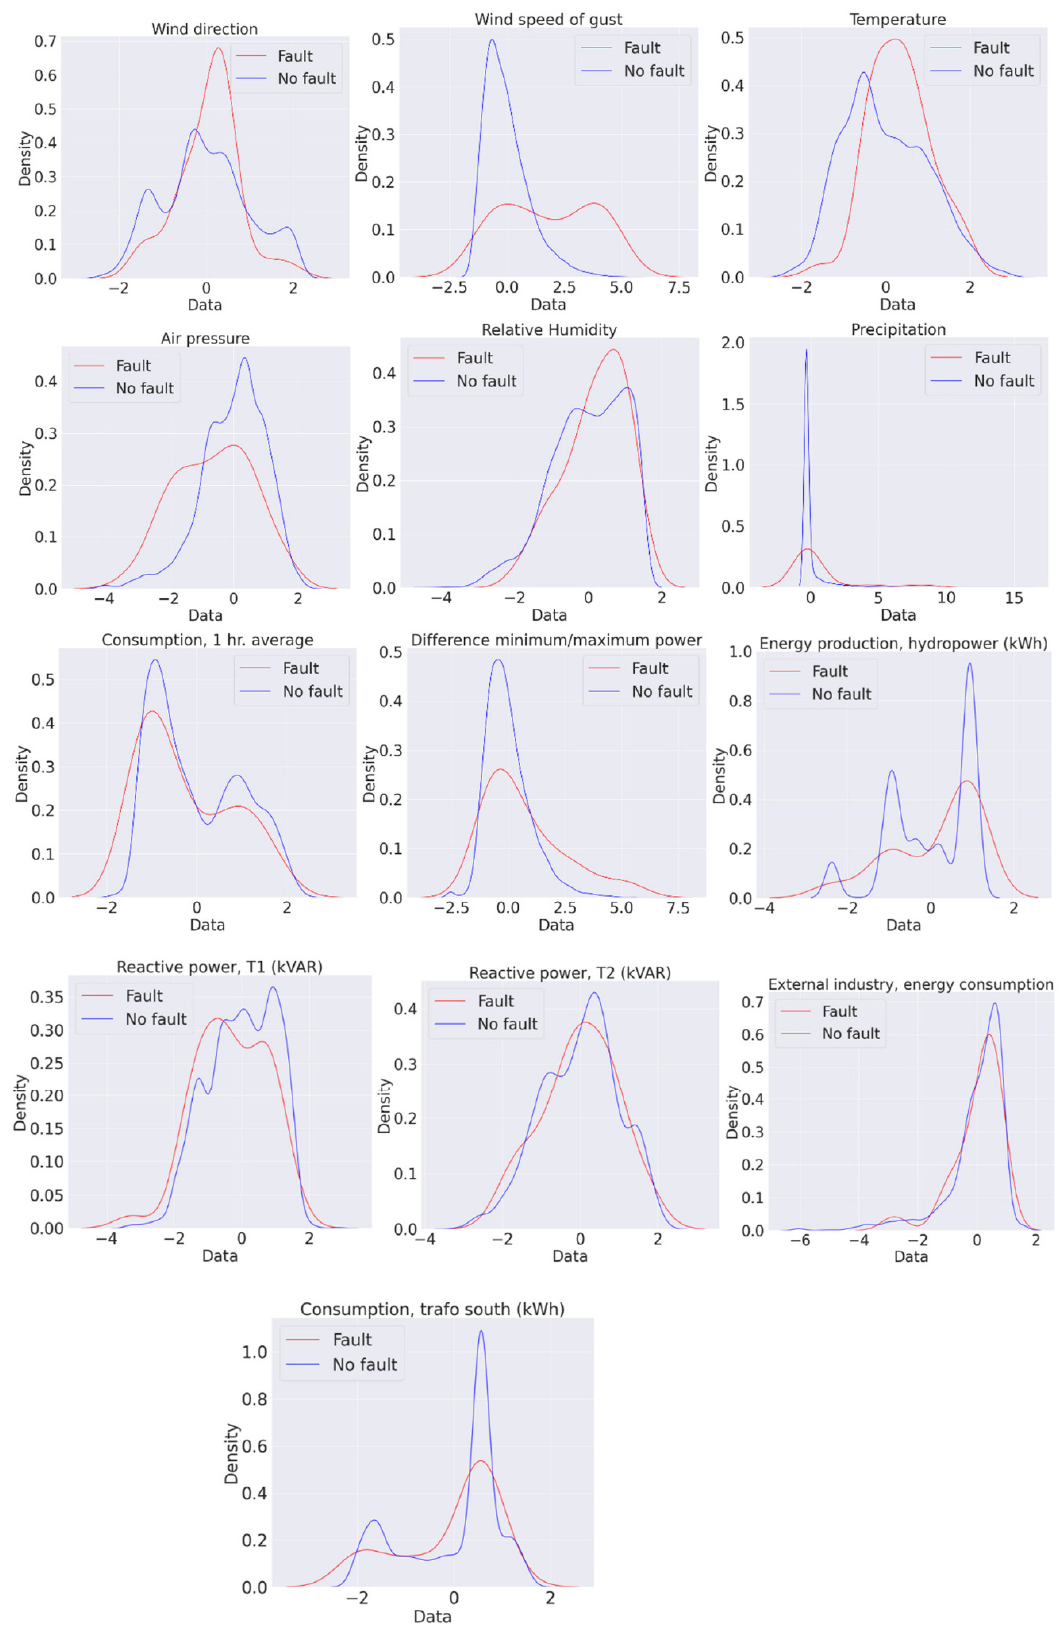
Figure 6. Normalized Gaussian Kernel Density Estimation of minority class (red) and majority class (blue) for each